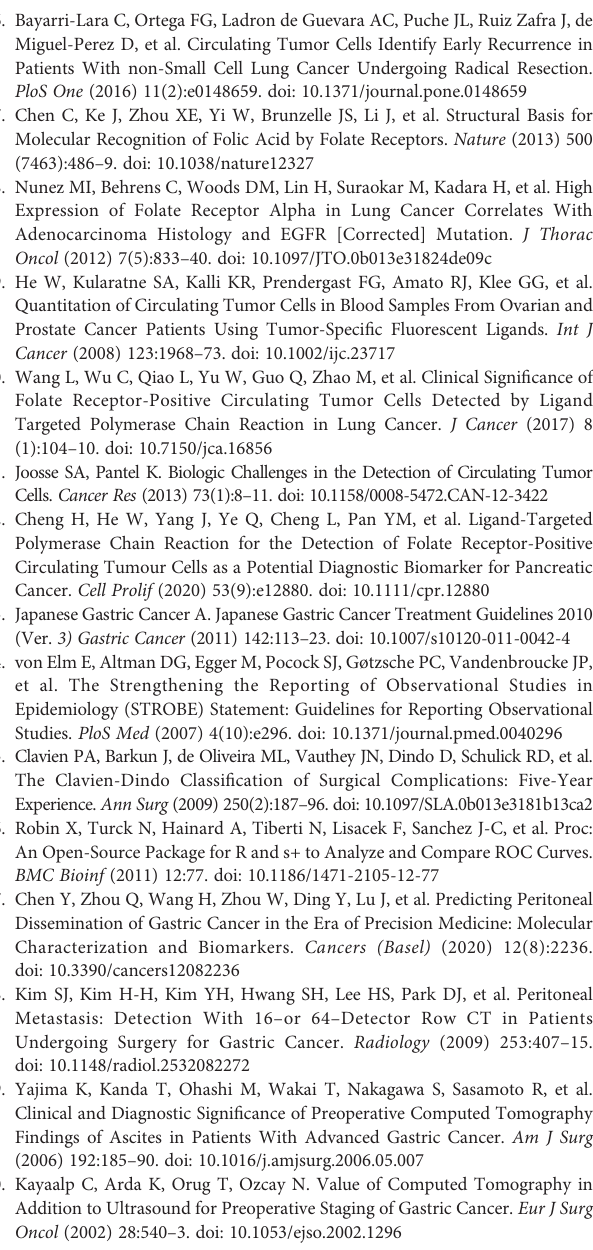
Supplementary Figure 1 | Comparison of recurrence free survival gastric cancer patients based on preoperative FR+CTCs and CA19-9 levels. Group A: patients without elevated FR+CTCs ( ≥ 12.6FU/3mL) and elevated CA19-9 (>34 ng/mL); Group B: patients with either elevated FR+CTCs ( ≥ 12.6FU/3mL) or elevated CA19- 9 (>34 ng/mL); Group C: patients with both elevated FR+CTCs ( ≥ 12.6FU/3mL) and elevated CA19-9 (>34